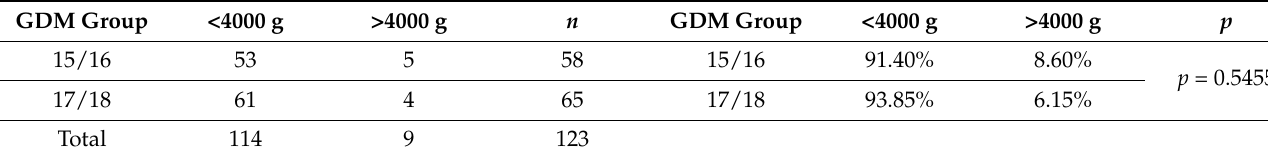
Table 3. Comparison of neonatal body weight at